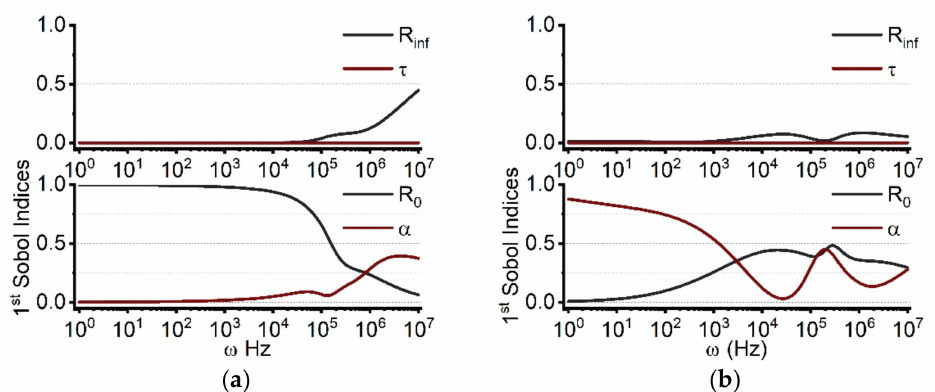
Figure 2. The parameter sensitivity distributions for the real ( a ) and imaginary ( b ) parts of the Cole impedance. The low frequency for the real part is determined by R 0 , while α amplifies the influence in the high frequency range. On the contrary, α mainly determines the low frequency for the imaginary part, and R 0 primarily determines the high